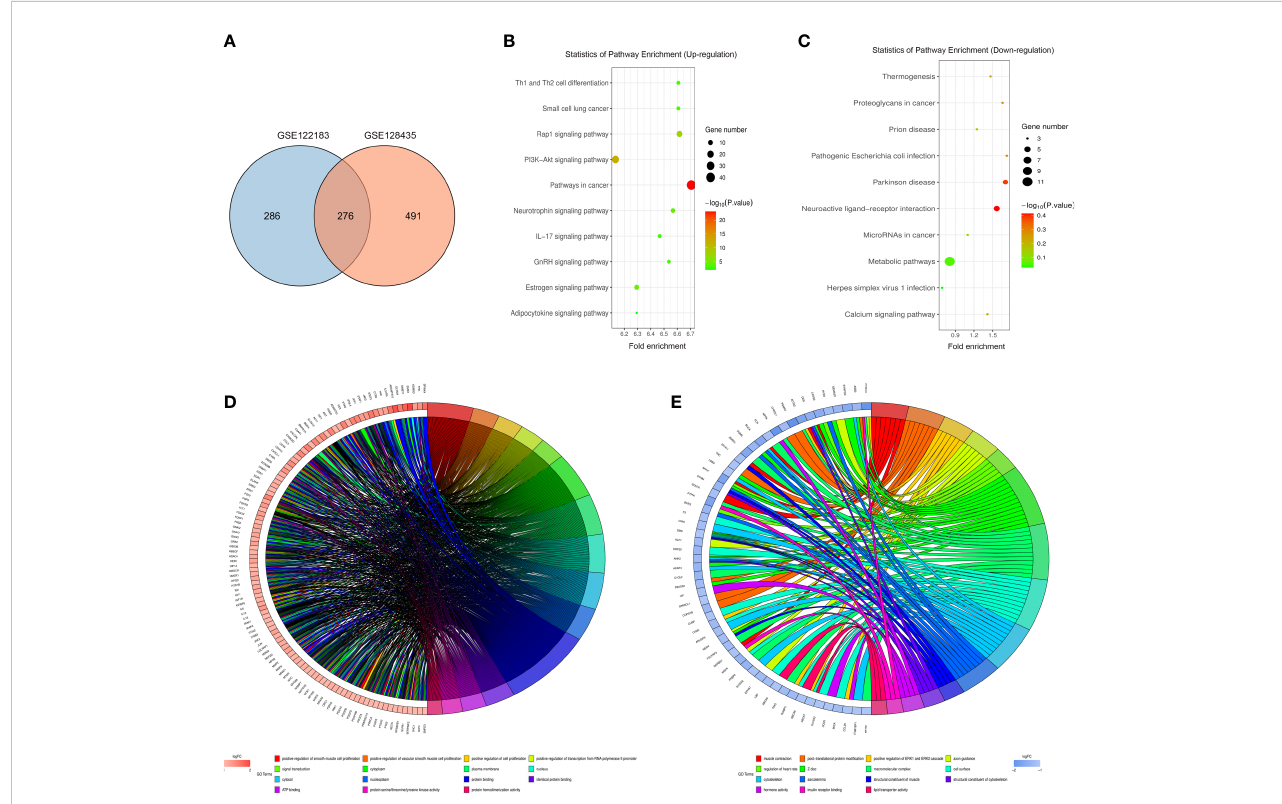
FIGURE 2 Bioinformatics analysis. (A) Common DEGs obtained from GSE122183 and GSE128435 were represented via Venn diagram; (B, C) Up-regulation and down-regulation KEGG pathway diagrams of DEGs were drawn via KEGG pathway analysis; (D, E) Biological process network of up-regulated DEGs and down-regulated DEGs. GO, Gene Ontology; KEGG, Kyoto Encyclopedia of Genes and Genomes; DEGs, differentially expressed